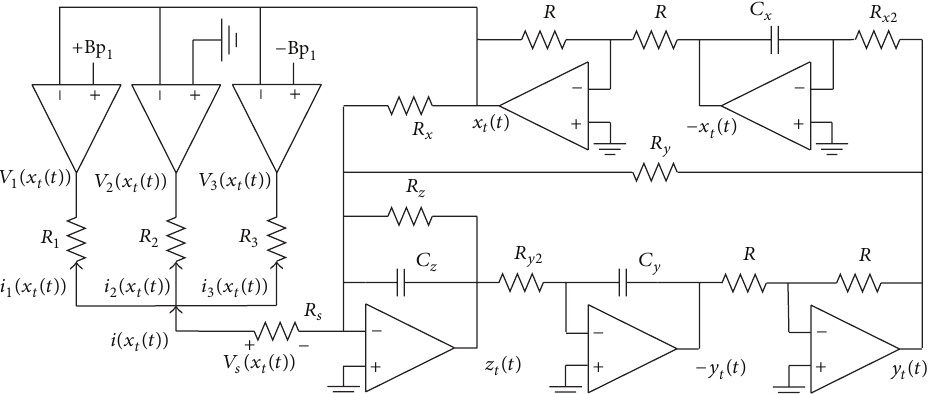
Figure 1: Multiscroll chaotic circuit based on Op Amps as